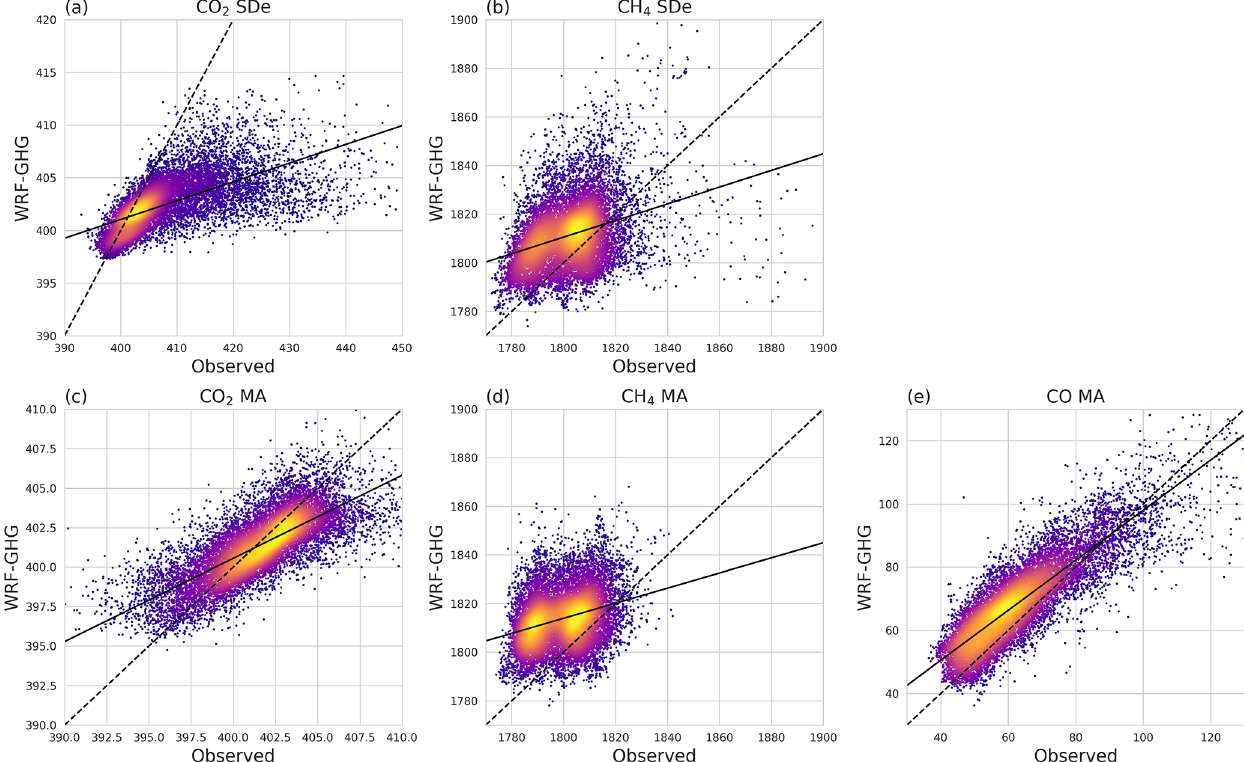
Figure 6. Scatterplot of hourly observed and modeled in situ greenhouse gases at SDe (a, b) and MA (c, d, e) . The colors indicate the point density.